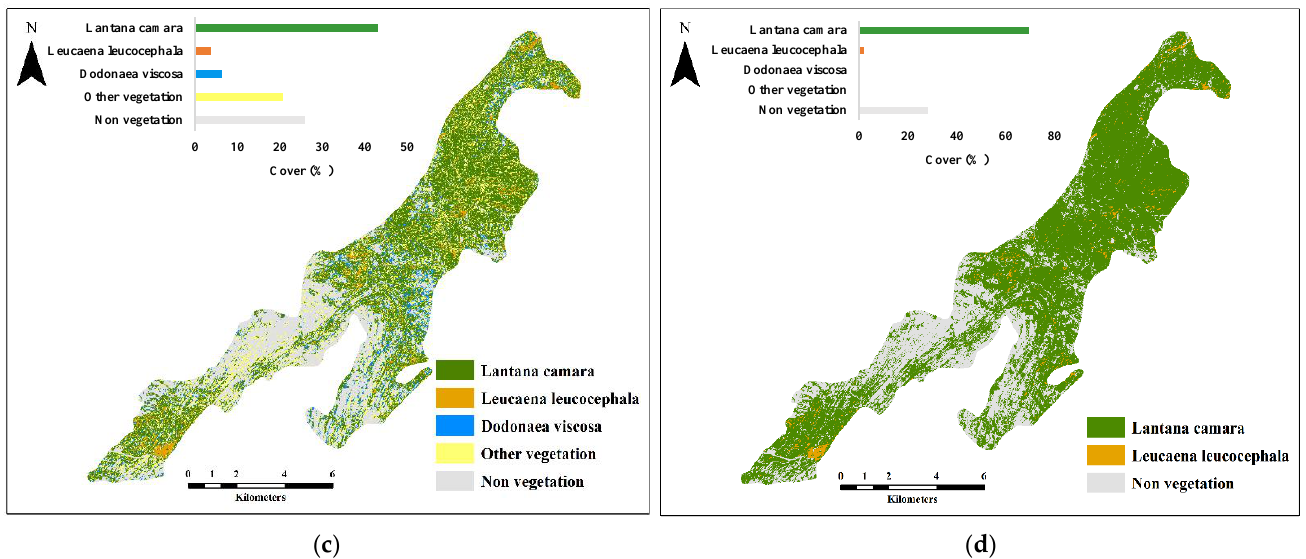
Figure 6. Distribution cover map of five classes in the Lehri – Jindi Reserve Forest generated through different classification approaches using Sentinel data. Random forest, ( a ) Gaussian mixture model, ( b ) k-nearest neighbour, ( c ) support vector machine ( d ).